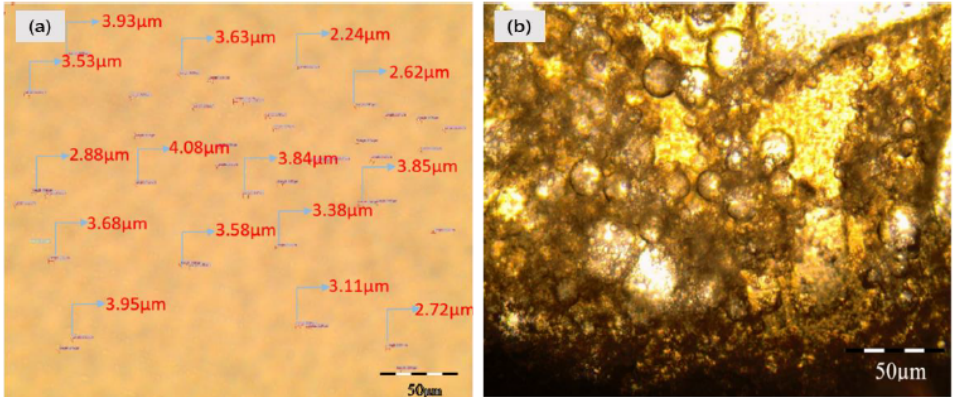
Figure 7. Cross polarized microscope (CPM) images of emulsions with and without TiO 2 nanopar- ticles; ( a ) CPM image of emulsion in the presence of Alkali: 500; Surfactant: 400 ppm; Polymer: 600 ppm; ( b ) CPM image of emulsion in the presence of Alkali: 500; Surfactant: 400 ppm; Polymer: 600 ppm and TiO 2 nanoparticles.